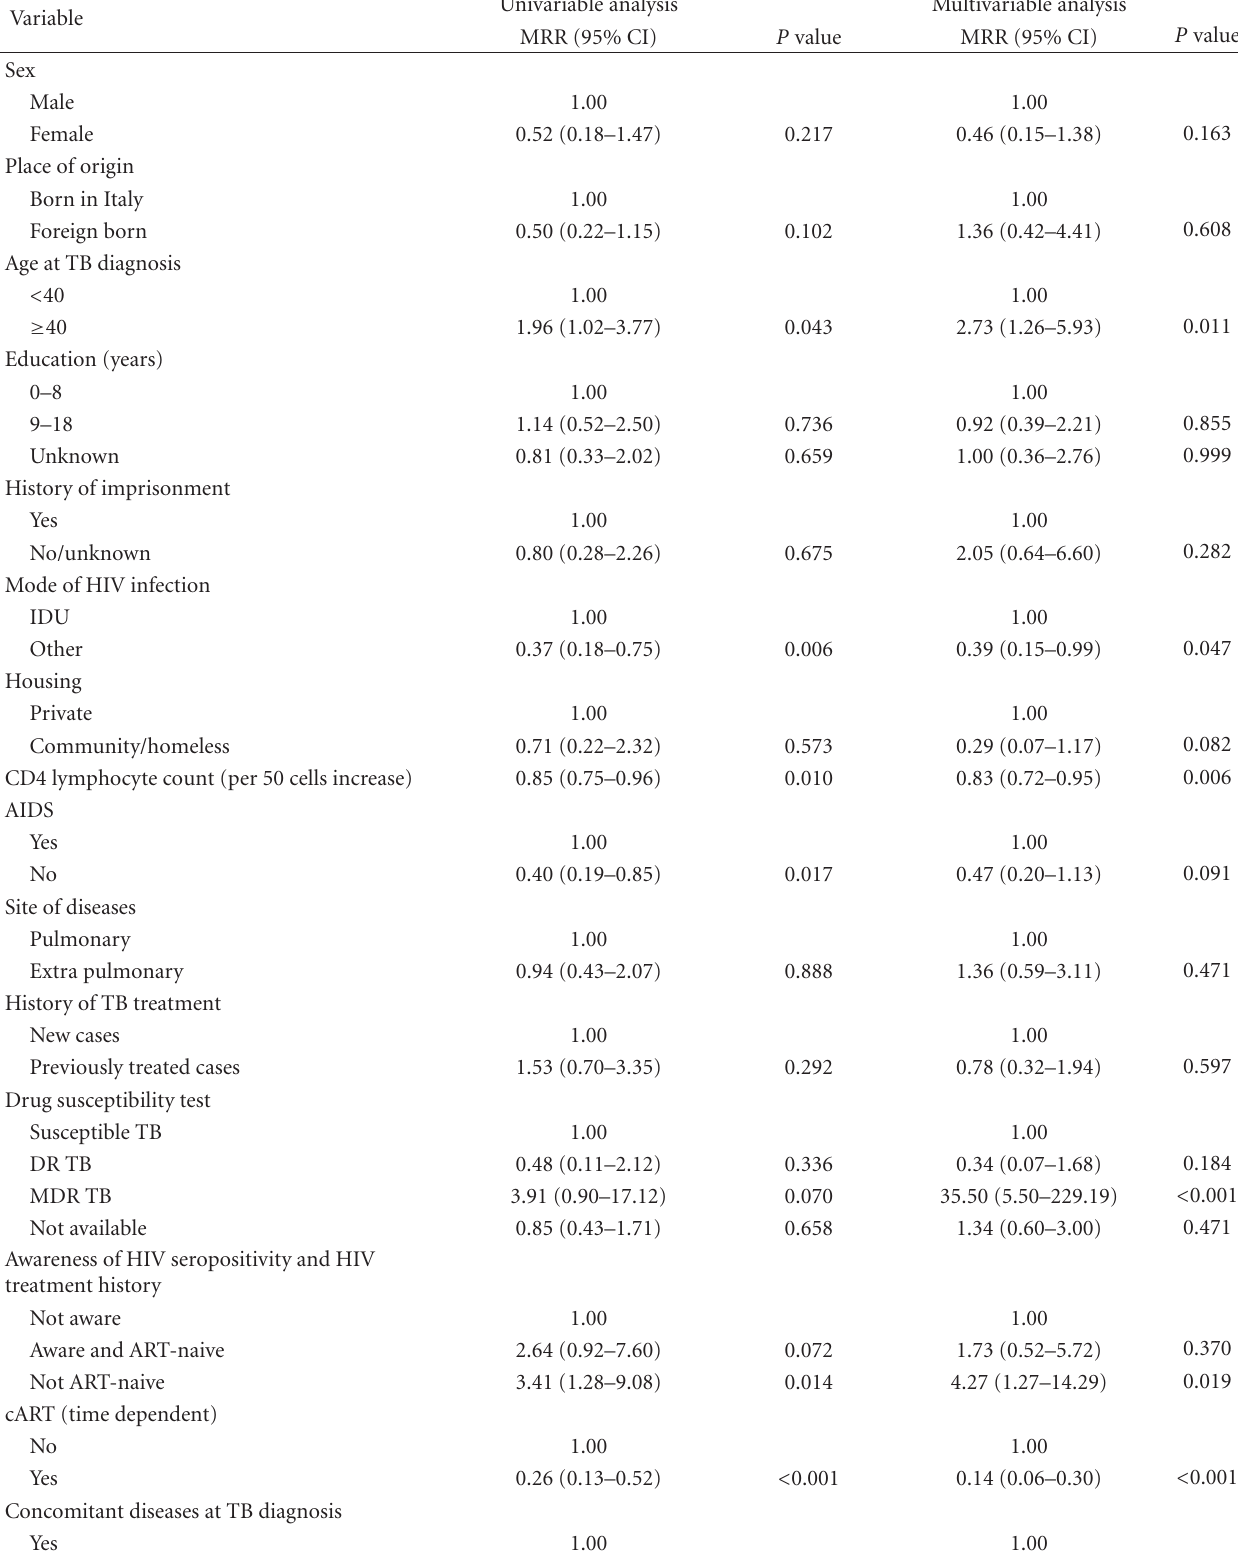
Table 3: Univariable and multivariable mortality rate ratio (MRR) ∗ for 246 HIV-infected patients with